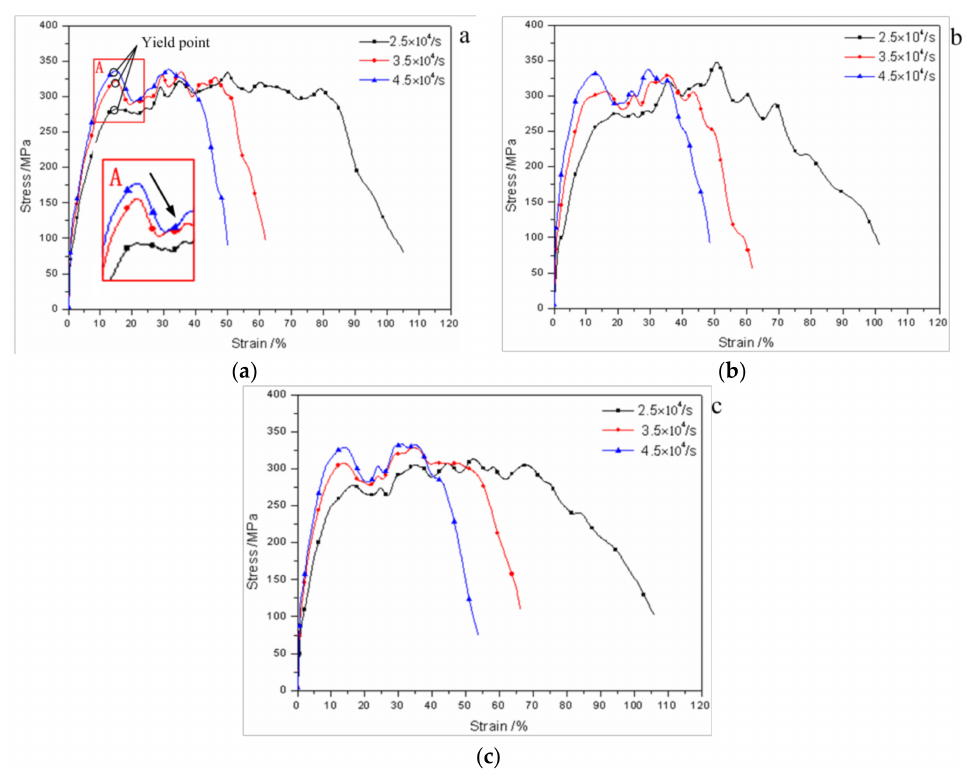
Figure 8. Dynamic stress-strain curves of different forming directions: ( a ) ND; ( b ) TD; ( c ) RD.